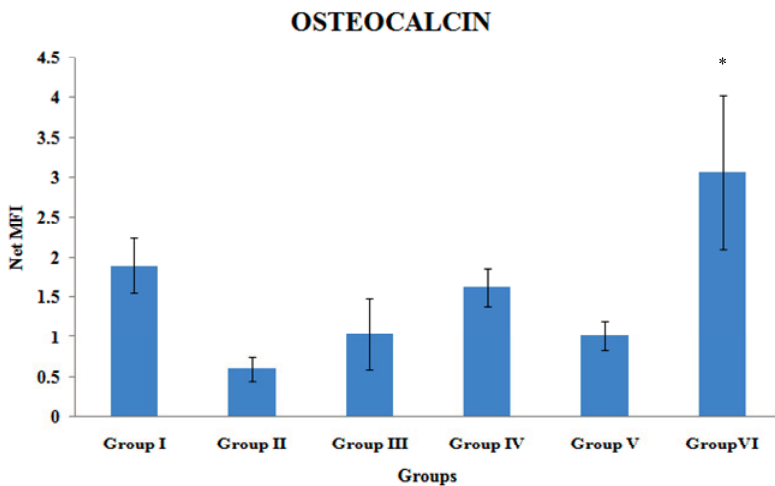
Figure 1. Osteocalcin gene expression. Samples were normalized to GAPDH MFI (Median Fluorescence Intensity). Values were expressed as mean ± SEM. Group I: sham-operated group, Group II: ovariectomized control group, Group III: ovariectomized+Estrogen, Group IV: ovariectomized+Lovastatin, Group V: ovariectomized+Tocotrienol, Group VI: ovariectomized+Tocotrienol+Lovastatin. * Indicates a significant difference ( p < 0.05) compared with the group II.